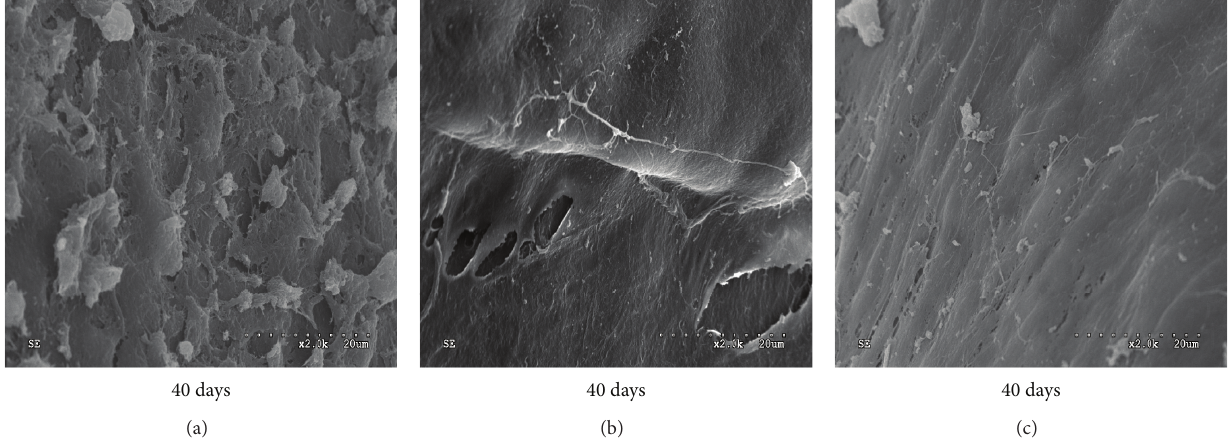
Figure 3: The scanning electron microscopy images of collagen fibers in repair area; magnification times of all pictures in Figure 3 are 2000. Pictures (a), (b), and (c) belong to groups A, B, and C, respectively.